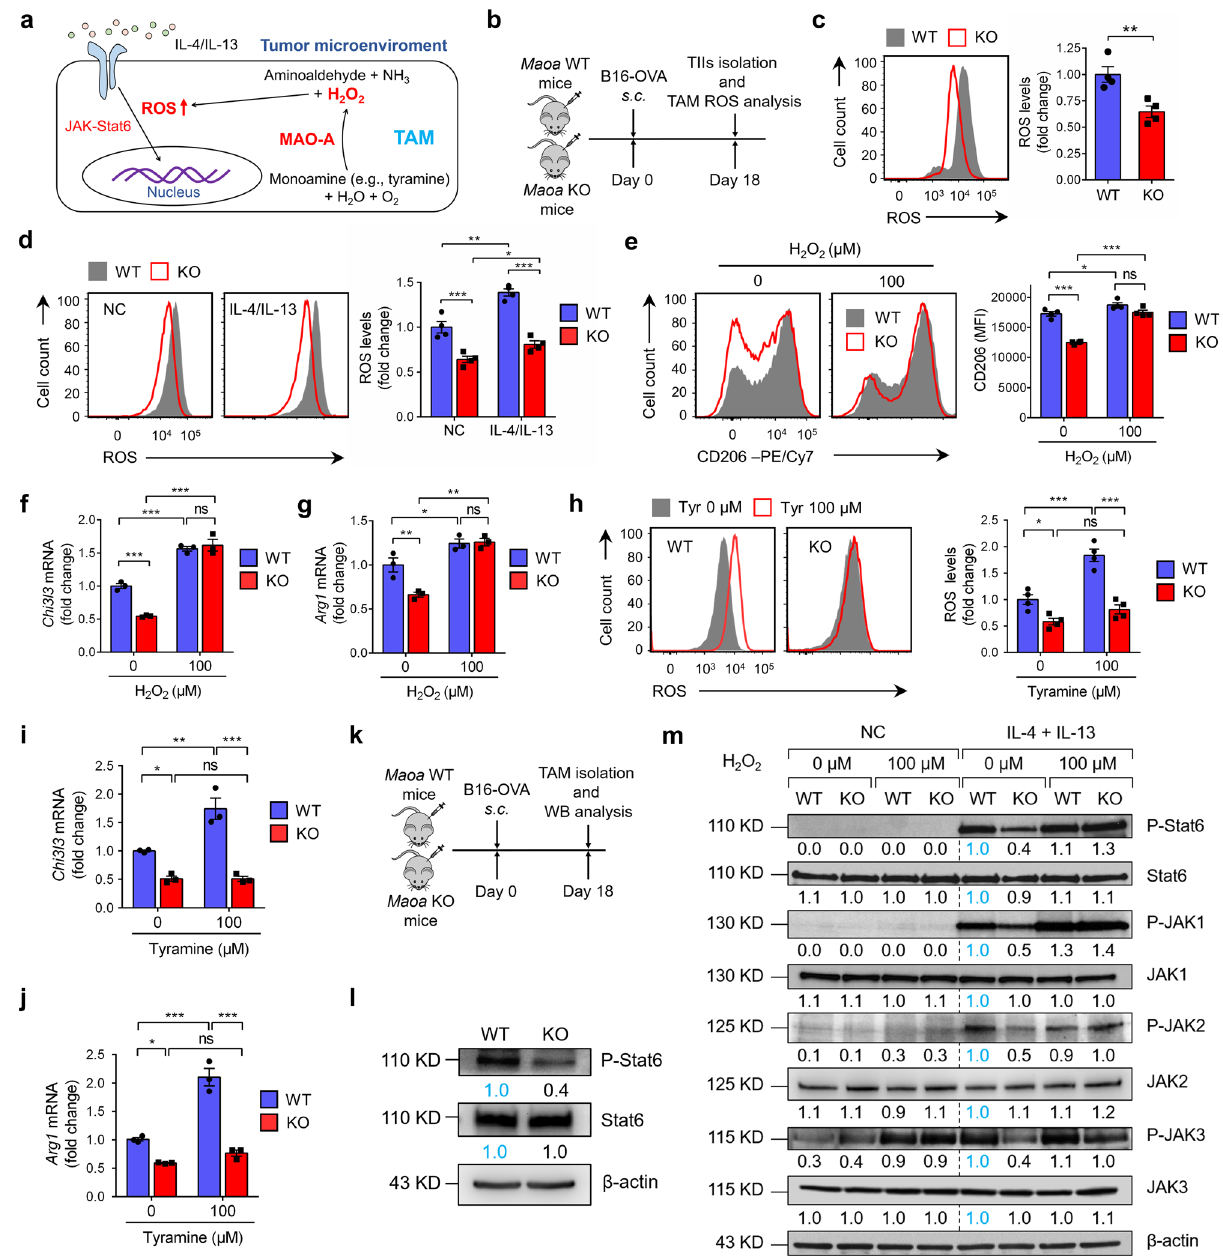
Fig. 4 MAO-A promotes macrophage immunosuppressive polarization via ROS upregulation. a Schematics showing MAO-A breaks down monoamines and generates hydrogen peroxide (H 2 O 2 ) as a by-product, thereby increasing reactive oxygen species (ROS) levels in a TAM. b , c Studying the in vivo ROS levels in TAMs isolated from Maoa WT and Maoa KO mice-bearing B16-OVA tumors ( n = 4). b Experimental design. c FACS analyses of ROS levels in TAMs at day 18. TAMs were gated as the CD45.2 + CD11b + Ly6G − Ly6C -/low F4/80 + cells of total TIIs (** p = 0.0088). d FACS analyses of ROS levels in in vitro-cultured Maoa WT and Maoa KO BMDMs, without or without IL-4/IL-13 polarization ( n = 4). NC no cytokine, IL-4/IL-13 IL-4/IL-13-polarized. * p < 0.05, ** p < 0.01 and *** p < 0.001. e – g Study of IL-4/IL-13-polarized Maoa WT and Maoa KO BMDMs, with or without H 2 O 2 treatment ( n = 3). e FACS analyses of CD206 expression. f , g QPCR analyses of Chi3l3 ( f ) and Arg1 ( g ) mRNA expression. * p < 0.05, ** p < 0.01 and *** p < 0.001. h – j Study of IL-4/IL- 13-polarized Maoa WT and Maoa KO BMDMs, with or without tyramine supplement ( n = 3). h FACS analyses of ROS levels. i , j QPCR analyses of Chi3l3 ( i ) and Arg1 ( j ) mRNA expression. * p < 0.05, ** p < 0.01 and *** p < 0.001. k , l Study of TAMs isolated from Maoa WT and Maoa KO mice-bearing B16-OVA tumors at day 18 (combined from fi ve mice per group). k Experimental design. l Western blot analyses of TAMs. TAMs were FACS sorted as the DAPI − CD45.2 + CD11b + Ly6G − Ly6C − /low F4/80 + cells from total TIIs. Source data are provided as a Source Data fi le. m Western blot analyses of JAK- Stat6 signalling in Maoa WT and Maoa KO BMDMs, with or without IL-4/IL-13 polarization and H 2 O 2 treatment. BMDMs were treated with H 2 O 2 for 30 min prior to IL-4/IL-13 stimulation for another 30 min. Representative of three experiments. Analysed by two-way ANOVA ( d – j ) or by Student ’ s t test ( c ). Statistics are all two-sided. Source data are provided as a Source Data fi le.